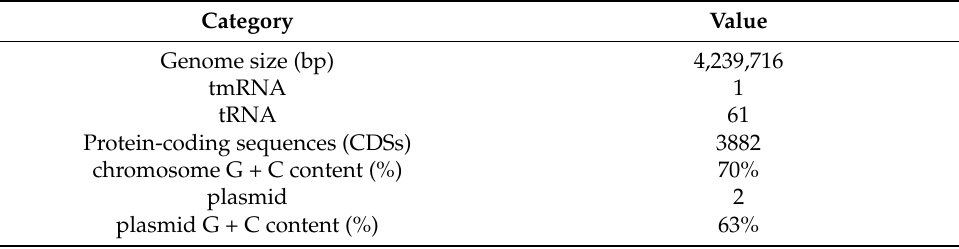
Table 1. Genome features of Sphingomonas morindae sp.